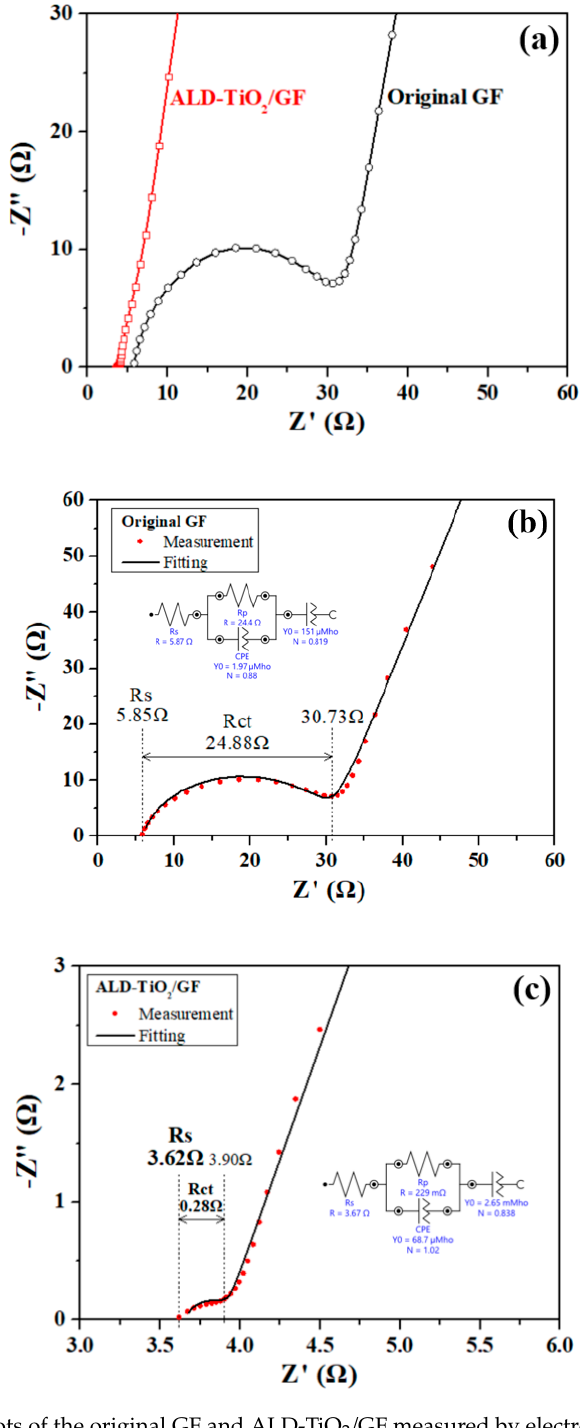
Figure 8. Nyquist plots of the original GF and ALD-TiO 2 /GF measured by electrochemical impedance spectroscopy (EIS) measurement. ( a ) Compared figure of the original GF and ALD-TiO 2 /GF, ( b ) and ( c ) show the experimental (red dots) and fitting (black line) data for the original GF and ALD-TiO 2 /GF, respectively.